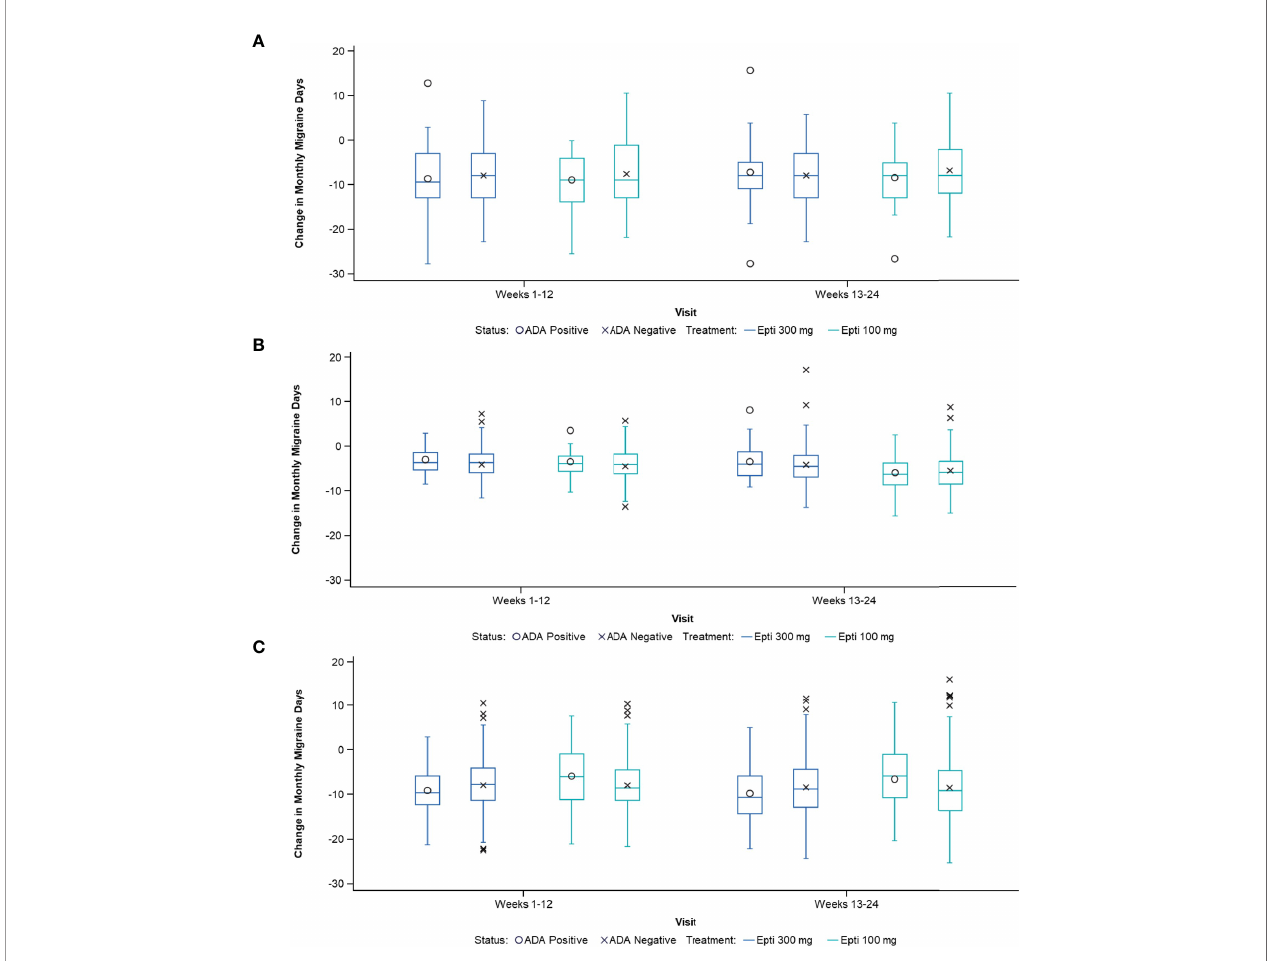
FIGURE 3 | Change in MMDs by ADA status in: (A) Study 2, (B) PROMISE-1, and (C) PROMISE-2. ADA, anti-drug antibody; Epti, eptinezumab, MMDs, monthly migraine days.